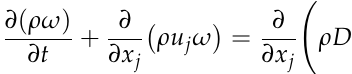
Table 2. Coordinates of different measuring point.